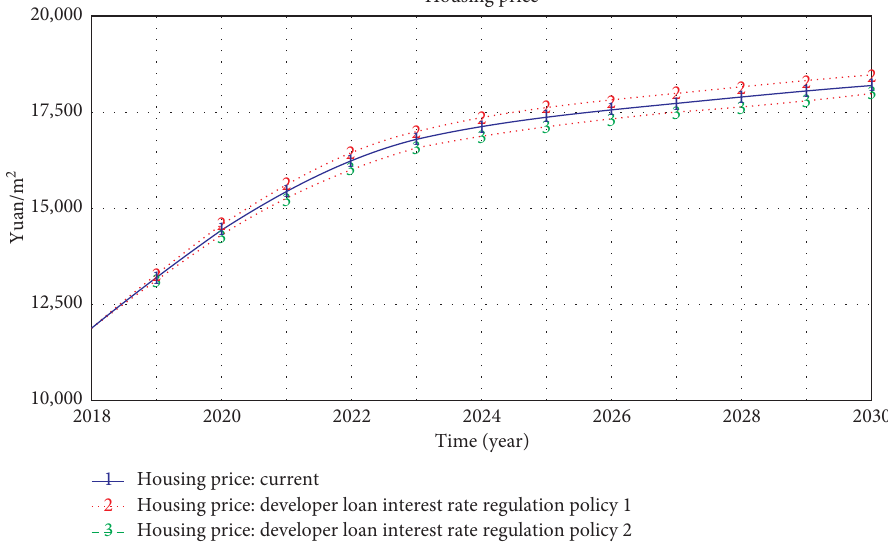
Figure 13: Influence of developer loan interest rate policy regulation on housing price. Table 12: Comparison table of housing prices under the regulation of developer loan interest rate policy.